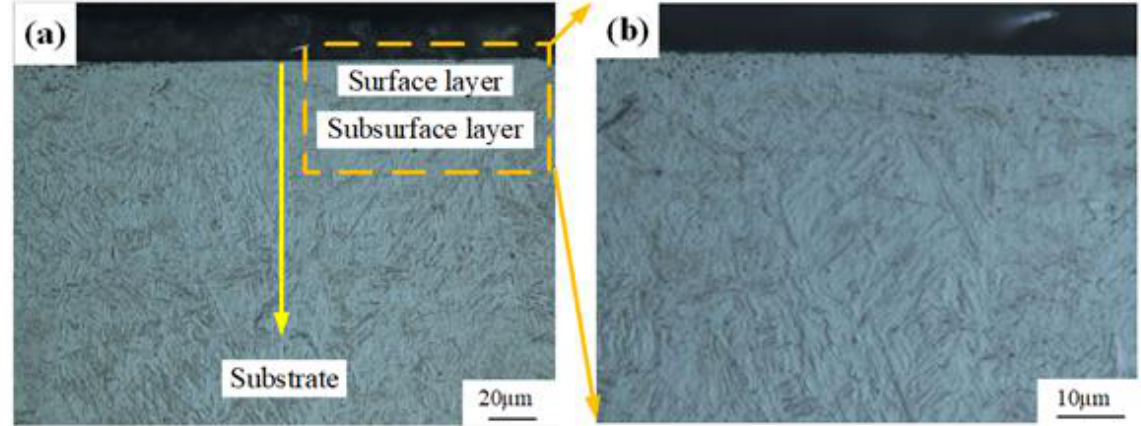
7 of 17 Figure 6. Microhardness of samples machined under different cutting parameters: ( a ) cutting speed, ( b ) feed rate, and ( c ) cutting depth. Figure 7. Cutting temperatures obtained under different cutting parameters: ( a ) cutting speed, ( b ) feed rate, and ( c ) cutting depth.